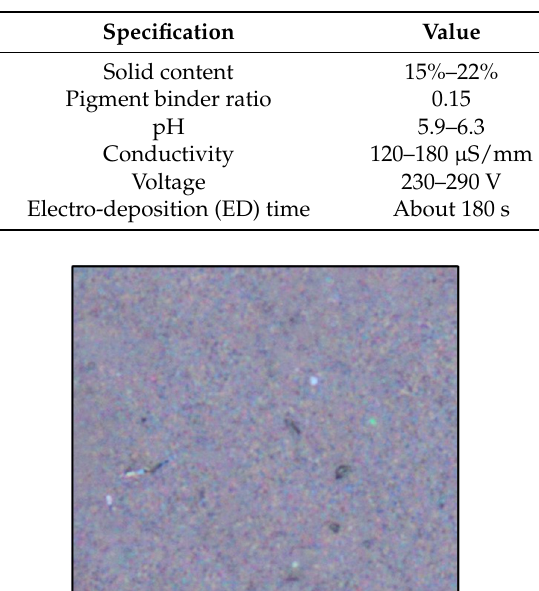
Figure 2. Microstructure image of an electro ‐ deposited coating.